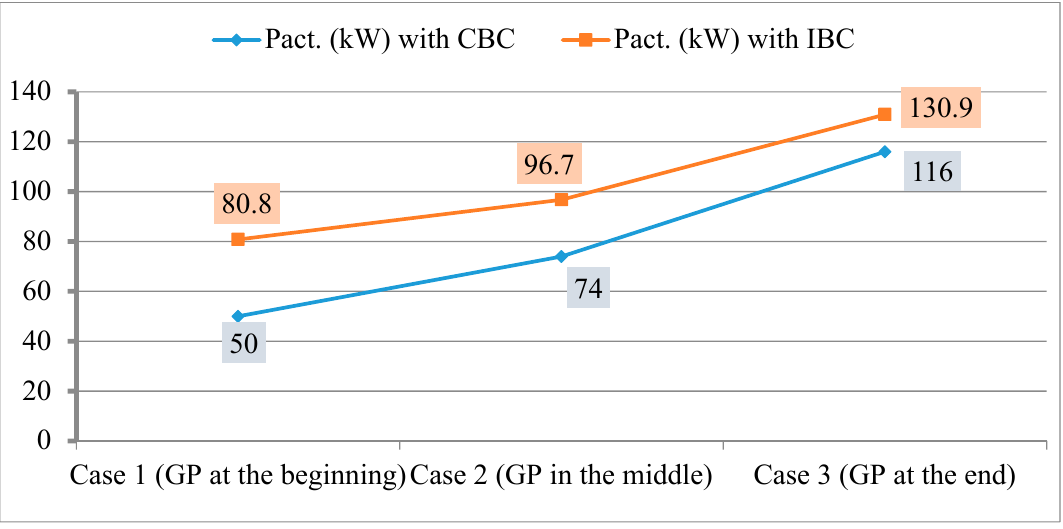
Figure 10. The actual power generated from the PSPV system with CBC and IBC for the three cases of PS.